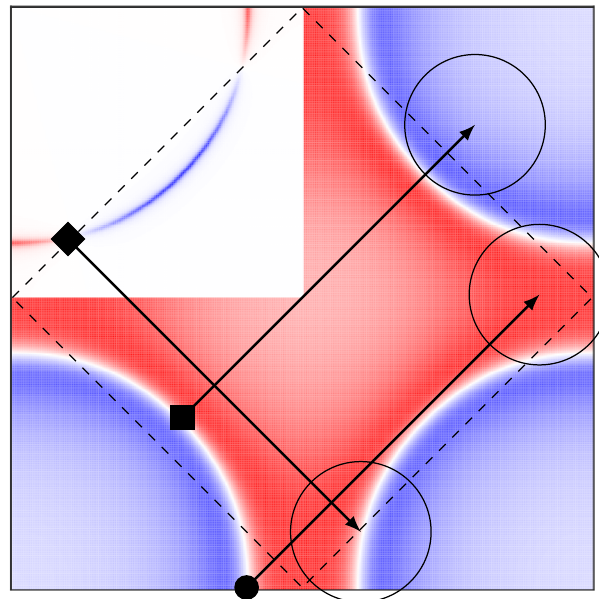
Fig. 1 Top left quadrant: damping (red) and antidamping (blue) on the Fermi surface (FS). Right and bottom quadrants: real part of the noninteracting Green ’ s function. Blue (red) color indicates particle-like (hole-like) states above (below) the Fermi level. Filled symbols: antinode (circle), node (square), hot spot (diamond). Arrows represent the antiferromagnetic wave vector Q . Open circles ~ 1/ ξ comprise available target states; red (blue) states are occupied (unoccupied) and promote damping (antidamping). Dashed lines show the antiferromagnetic zone boundary